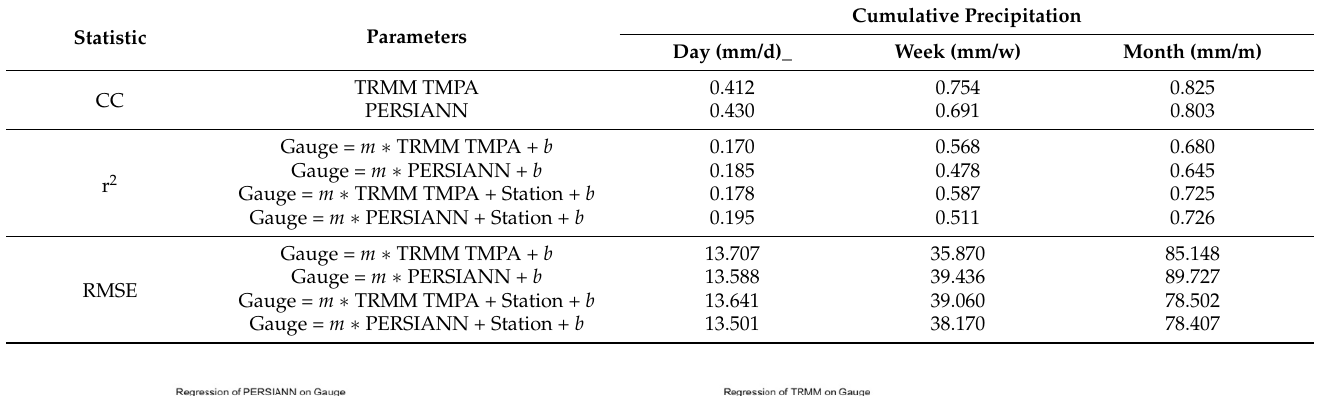
Table 3. Correlation coefficient (CC), r-squared (r 2 ), and root mean square error (RMSE) results for daily, weekly, and monthly data.